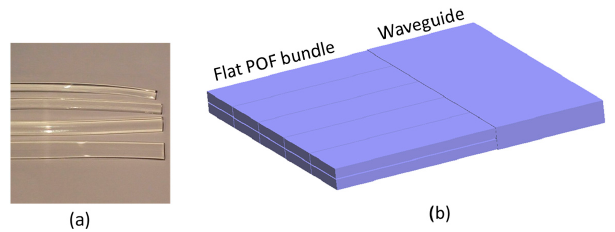
Figure 12. ( a ) Commercial flat POF with different sizes; ( b ) Alternative approach for optical fiber–planar waveguide coupling using a bundle of flat